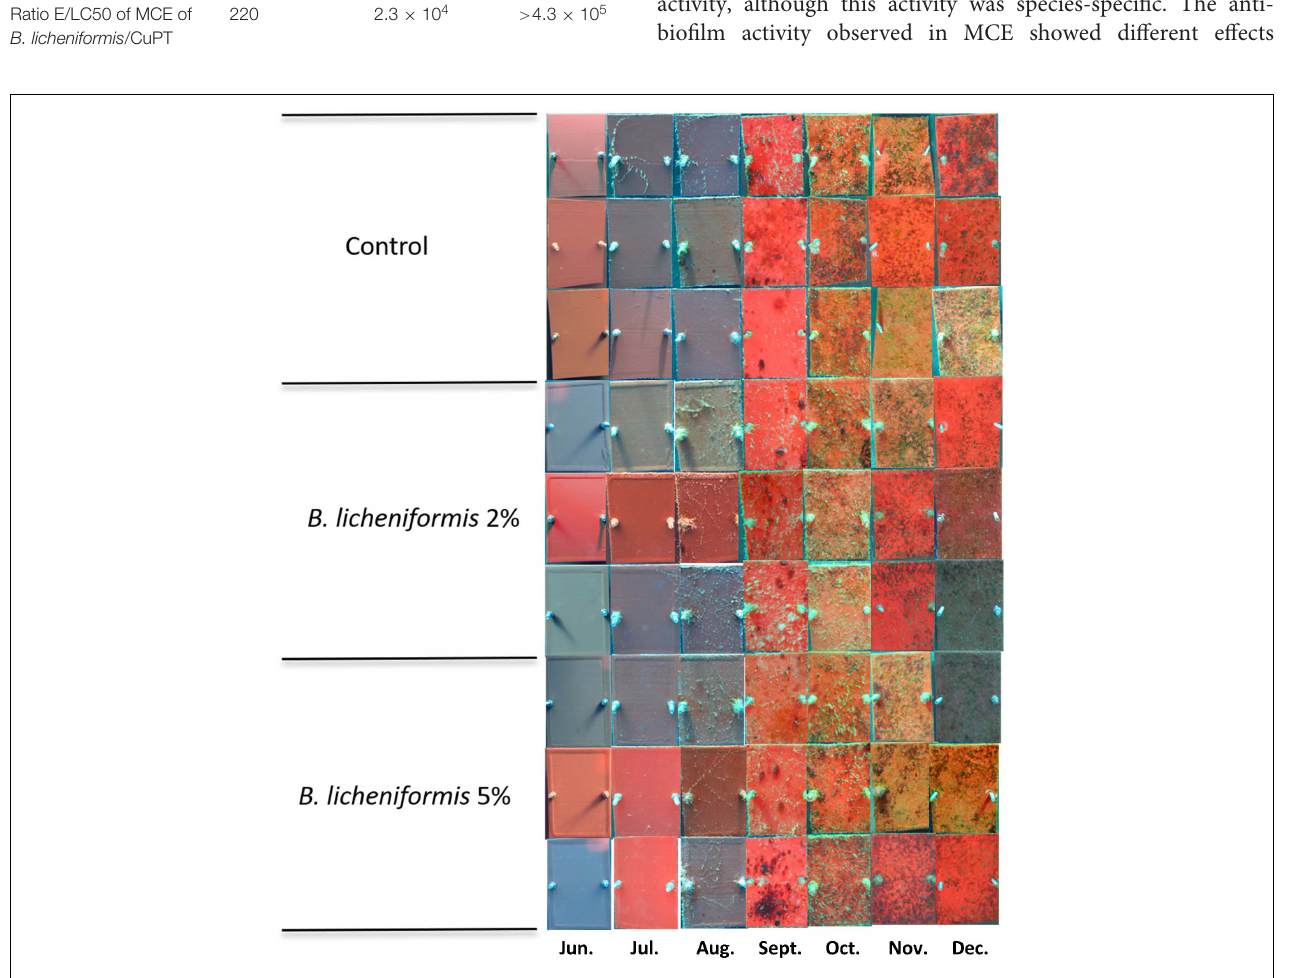
FIGURE 6 | Panels of the static immersion experiment featuring fouling growth from June to December 2016 in the Red Sea (29.501451 ◦ N, 34.916285 ◦ E) photographed monthly starting from day 0. The Bacillus licheniformis methanol cell extract (MCE) was incorporated at 2 and 5% w/w in a solvent-based self-polishing coating test product from Jotun without biocides. Differences in the color of the panels are due to differences in the color of the matrix.